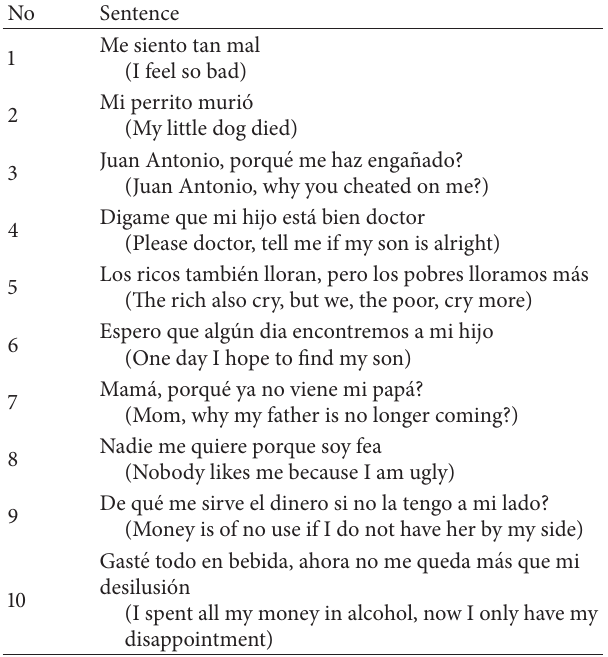
Table 3: Emotional stimuli: “neutro” (neutral).